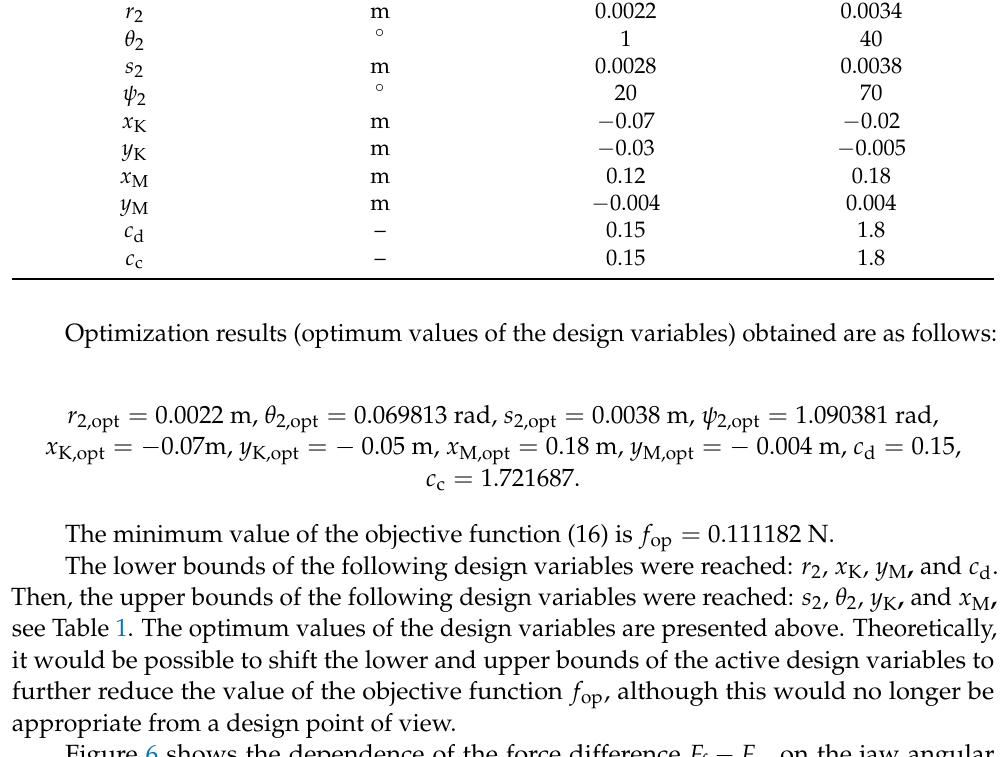
Figure 6. Dependence of the force difference F f − F gr on the jaw angular displacement θ